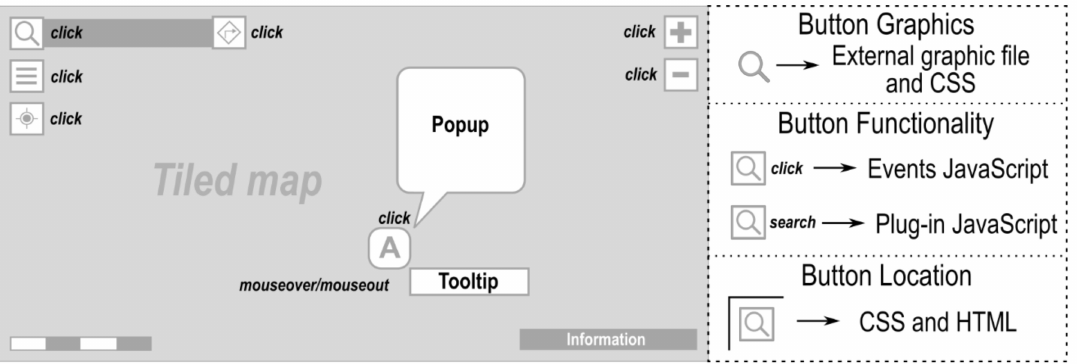
Figure 1. Web map GUI (Graphical User Interface) layout of buttons with interactive